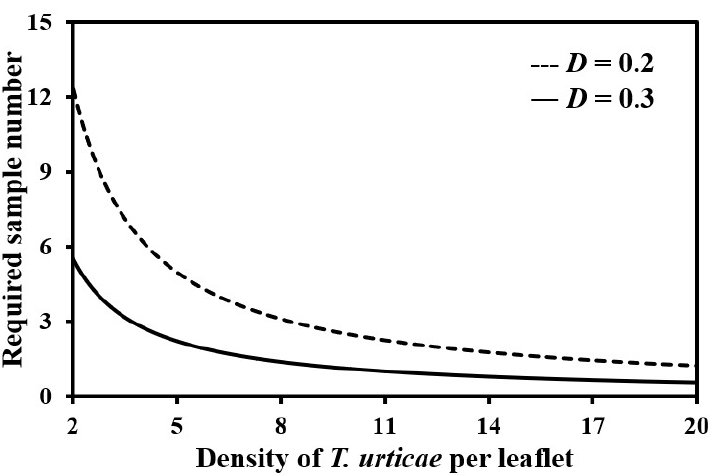
Figure 2. Required sample number according to densities of T. urticae per leaflet at fixed precision levels ( D ) of 0.2 (research purposes) and 0.3 (management purposes).